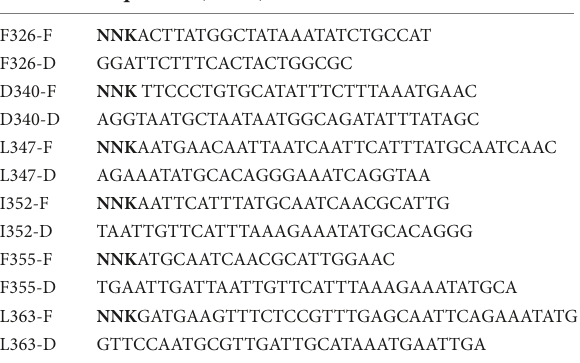
TABLE 1 The sequences of